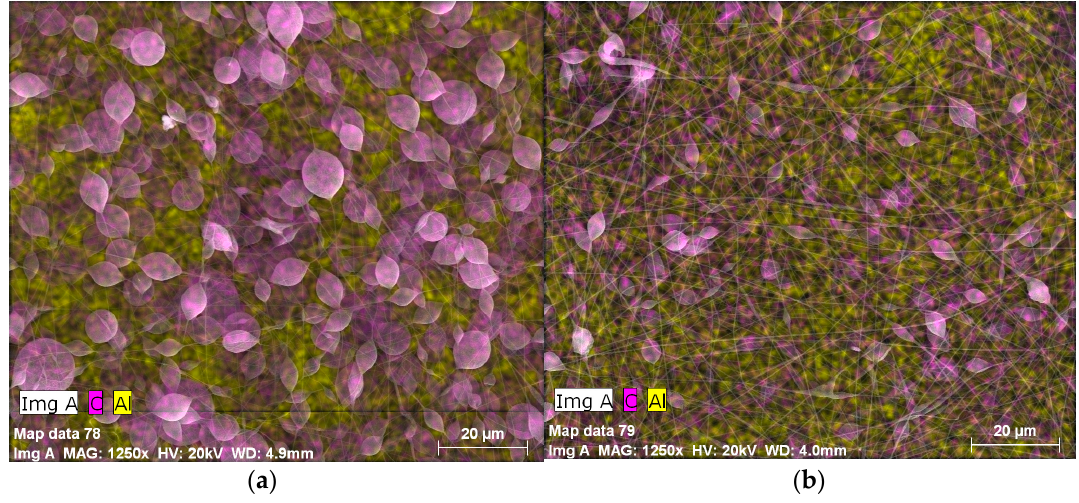
Figure 3. The SEM/EDX mapping micrographs of the as-prepared SHCS ( a ) PA1 and ( b ) PA3.